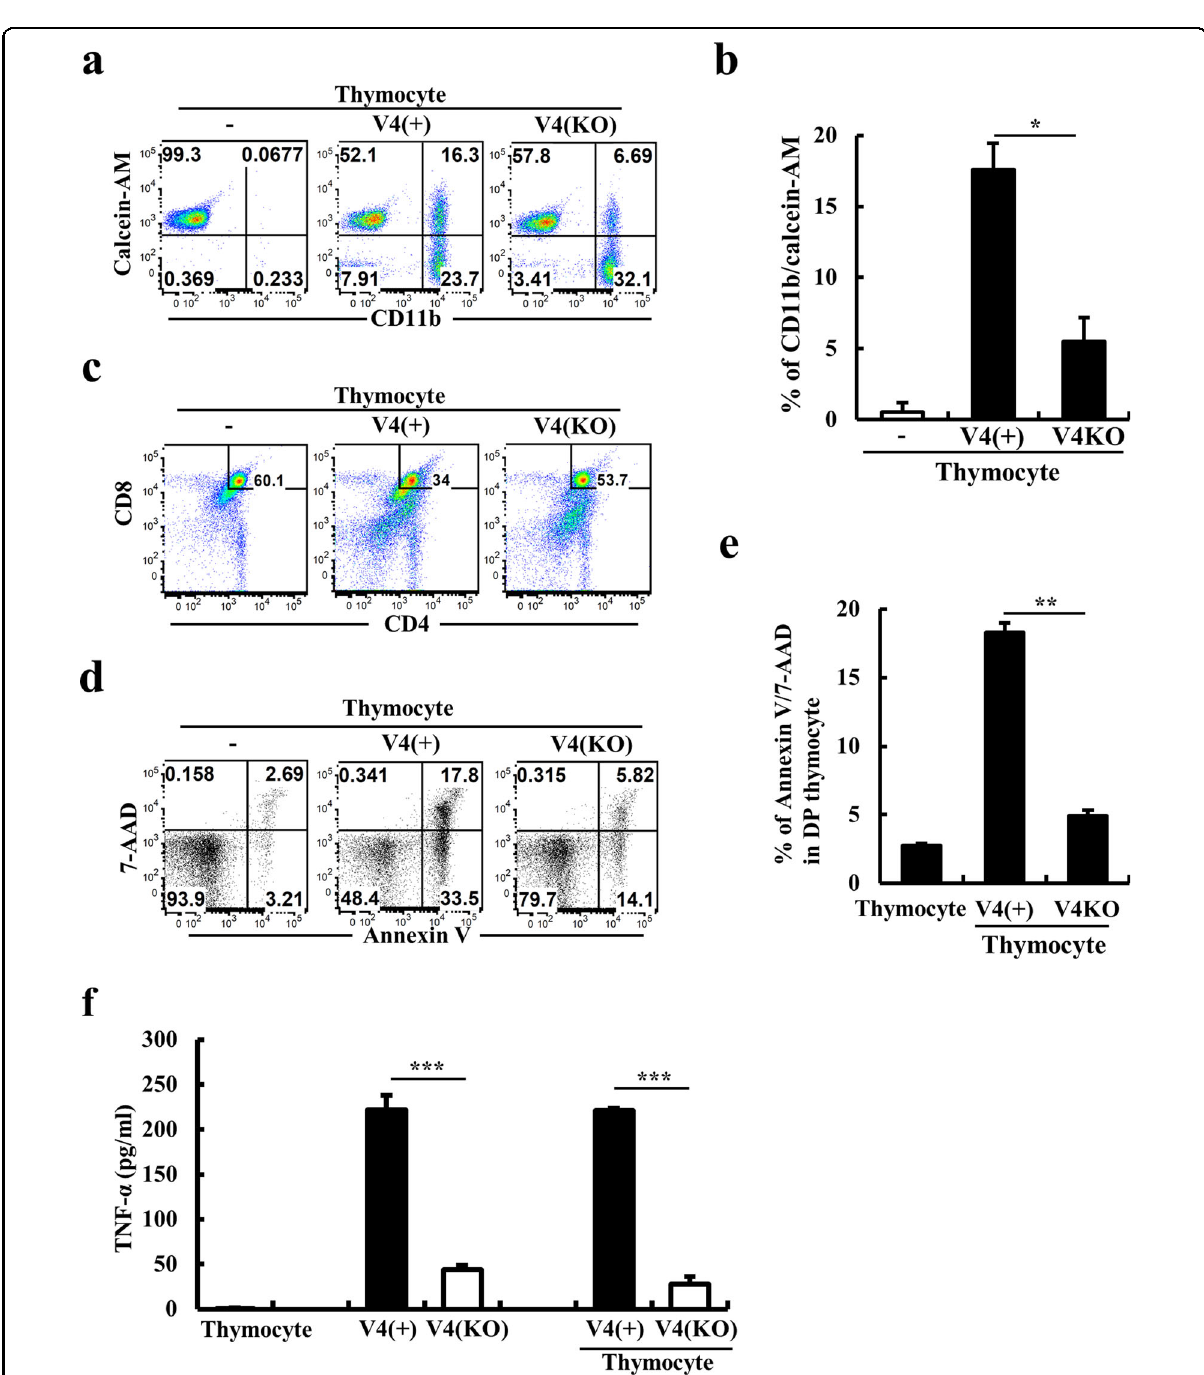
Fig. 7 Functional study using V4(KO) macrophages. a V4( + ) and V4(KO) macrophages were isolated from wild-type or V4(KO) mice using anti- VSIG4 or anti-CD11b antibody and MACS MicroBeads. Cells purity >95% was obtained. Thymocytes were stained with calcein-AM, and cocultured with puri fi ed V4( + ) and V4(KO) cells for 6 h. After culture, the cells were stained for CD11b, and calcein-AM activity was analyzed by fl ow cytometry. b Fluorescence intensity of calcein-AM in cells was estimated by fl ow cytometry. c Thymocytes were cocultured with V4( + ) or V4(KO) macrophages (2:1) for 17 h, and stained with anti-CD4 and anti-CD8 antibodies. Then, the cells were analyzed by fl ow cytometry. d The cells as shown in ( c ) were stained with Annexin V and 7-AAD, and apoptosis in the gated DP thymocytes was measured using fl ow cytometry. The data represent the average value of triplicates. e The cells as shown in ( d ) were stained with Annexin V and 7-AAD, and apoptosis in the gated DP thymocytes was analyzed by fl ow cytometry. f V4( + ) and V4(KO) macrophages prepared in ( a ) were cultured with or without thymocyte for 17 h. The concentration of TNF- α in culture supernatants was measured. The data represent the mean ± S.E.M. of three separate experiments. * p < 0.05, *** p < 0.001, ANOVA.